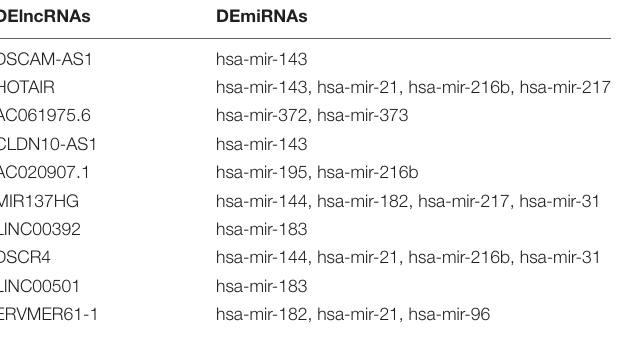
TABLE 2 | The top 10 DElncRNAs in the ceRNA network were targeted by DEmiRNAs.